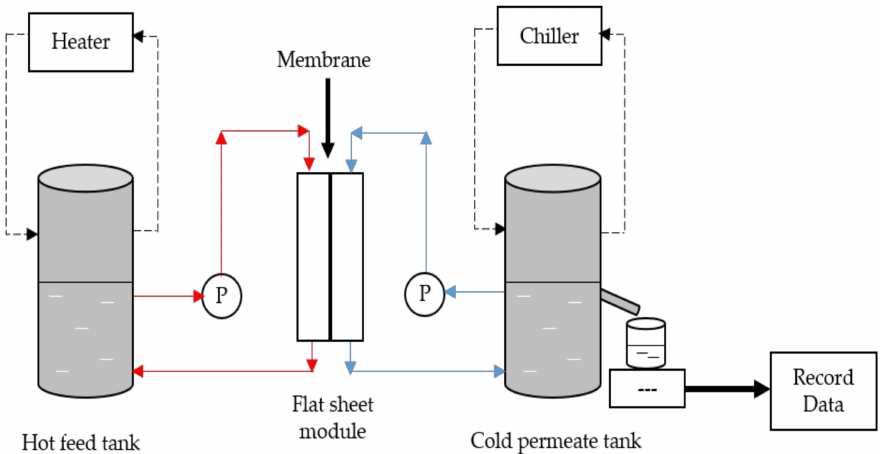
Figure 1. Set-up of direct contact membrane distillation (DCMD) operation process. The cross- flow membranes were carried out at constant temperature at feed and permeate sides for all the prepared membranes.